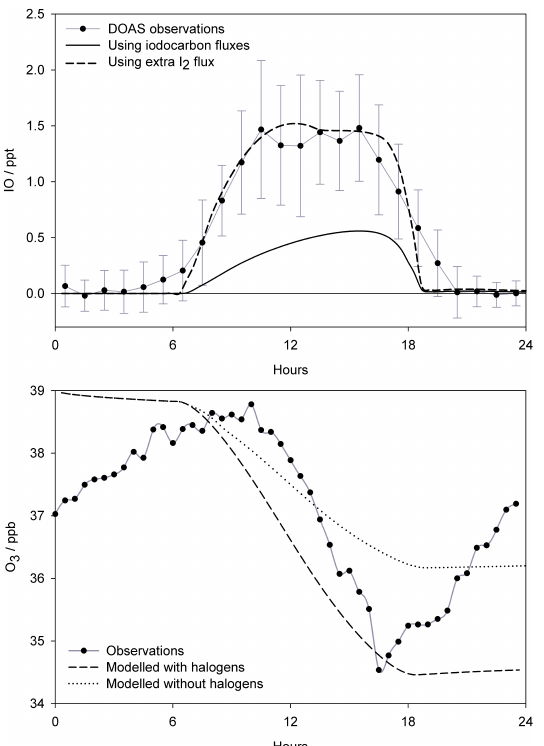
Fig. 3. Observed diurnal IO mixing ratios and O 3 destruction during May 2007 at Cape Verde (Read et al., 2008) compared with model predicted O 3 at the height of measurements (10m). In the absence of halogens, the model predicts the loss of only 2.5nmolmol − 1 in one day, while in the presence of halogens, this loss is ∼ 4.4nmolmol − 1 . Local noon is at GMT-1.